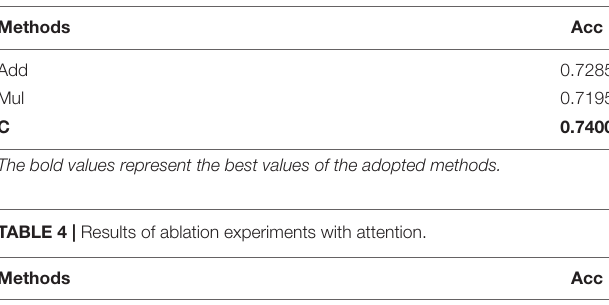
TABLE 3 | Results of ablation experiments with feature fusion.